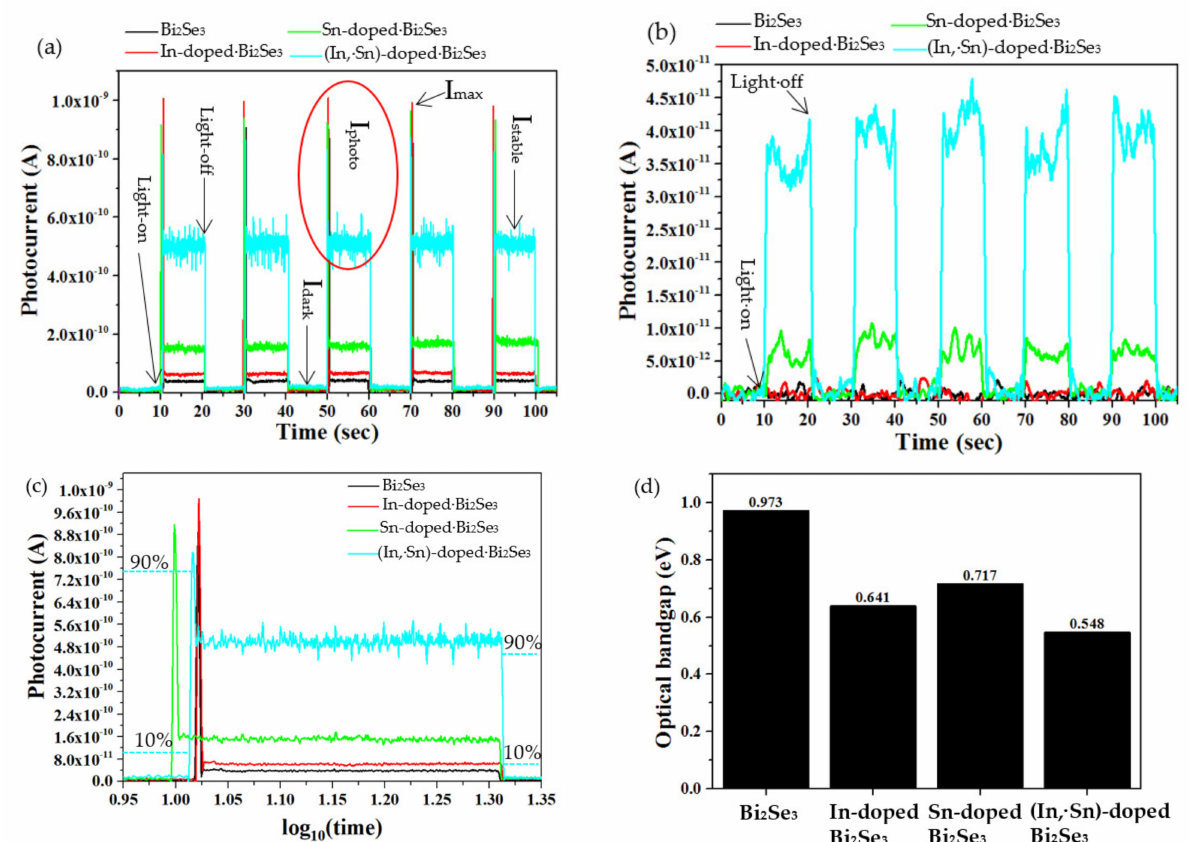
Figure 6. Photocurrent plots of pristine, and In-, Sn-, and (In, Sn)-doped Bi 2 Se 3 nanoplatelets under ( a ) UV (8 W) and ( b ) red light (5 W). ( c ) The variations of the log 10 (time) vs. the photocurrents between the pristine, and In-, Sn-, and (In,Sn)- doped Bi 2 Se 3 nanoplatelets in the first run of the light-on/light-off cycle. ( d ) The estimated optical bandgap energies. Table 5. Details of photocurrent measurements of the I max , I stable , ∆ I decay , τ r , t decay , τ f , and I photo /I dark ratios under the UV light.